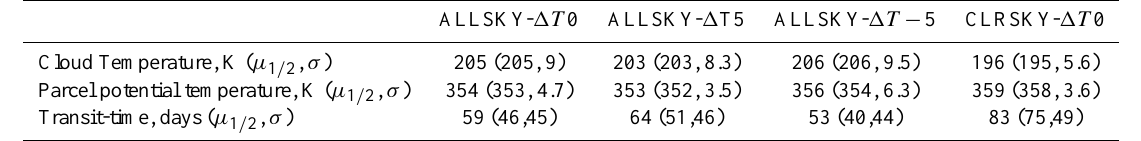
Table 3. Same as Table 1 but this time the focus is on all four CS-TTL ensembles, obtained for transport in all-sky and clear-sky conditions.